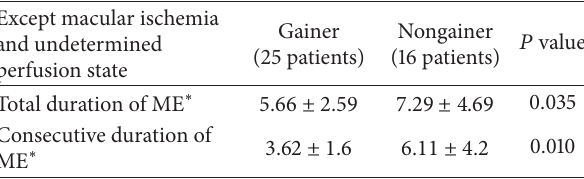
Table 5: Analysis of duration of ME between 2 groups after exclusion of macular ischemia and undetermined perfusion